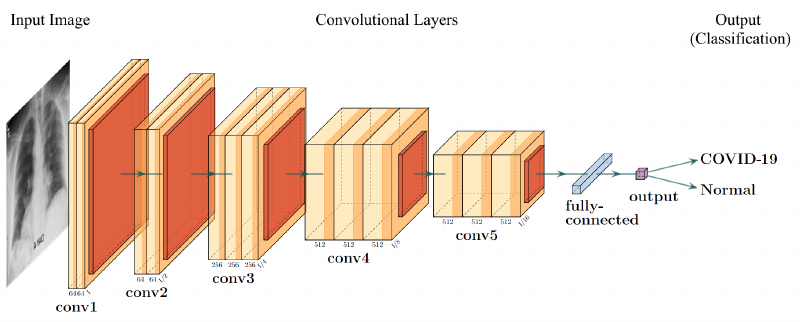
Figure 5. The structure of VGG-16 model adapted for prediction of COVID-19 using CXR.